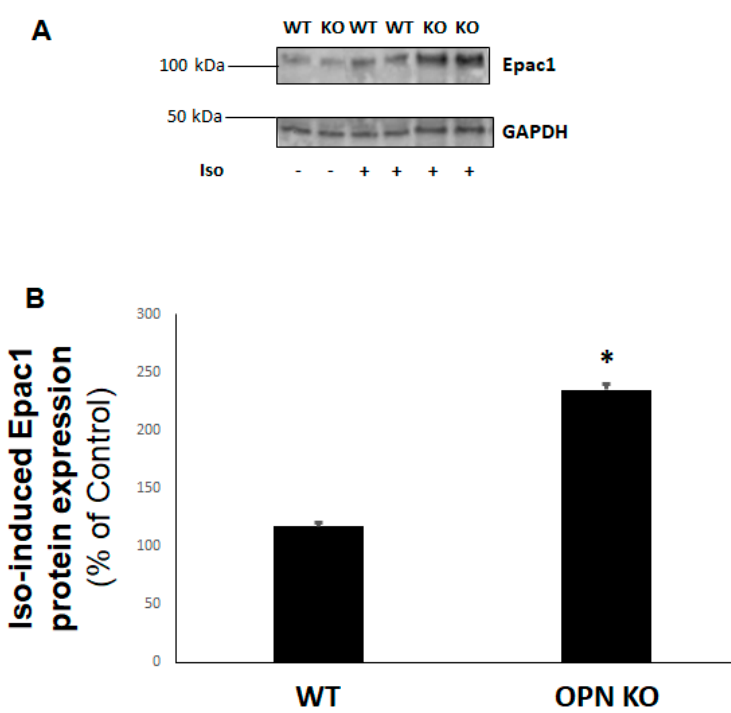
Figure 3. Enhanced β AR-dependent Epac1 protein levels in the absence of OPN in H9c2 cardiomyocytes (Epac: exchange protein directly activated by cAMP). H9c2 cells were treated with 10 µ M isoproterenol (Iso) or vehicle for 24 h in the presence (WT) or absence (KO) of OPN, then cells were harvested and total protein extracts prepared for Epac1 immunoblotting. Representative blots are shown in ( A ), including GAPDH as loading control, and the densitometric quantitation of three independent experiments per condition performed in duplicate is shown in ( B ). *, p < 0.05, n = 3. Int. J. Mol. Sci. 2018 , 19 , x FOR PEER REVIEW